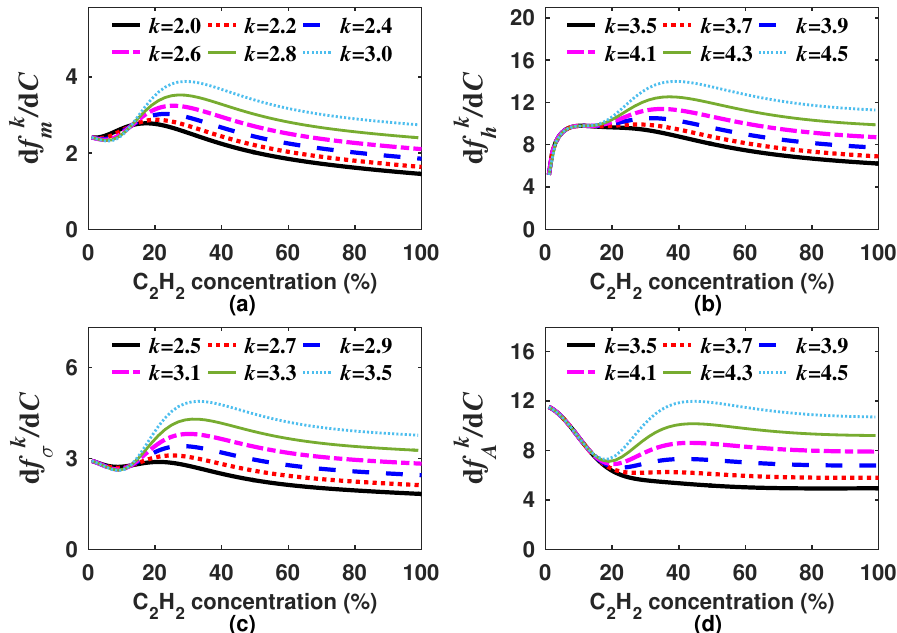
. ; ( c ) f k σ and ( d ) f k versus the C 2 H 2 A h